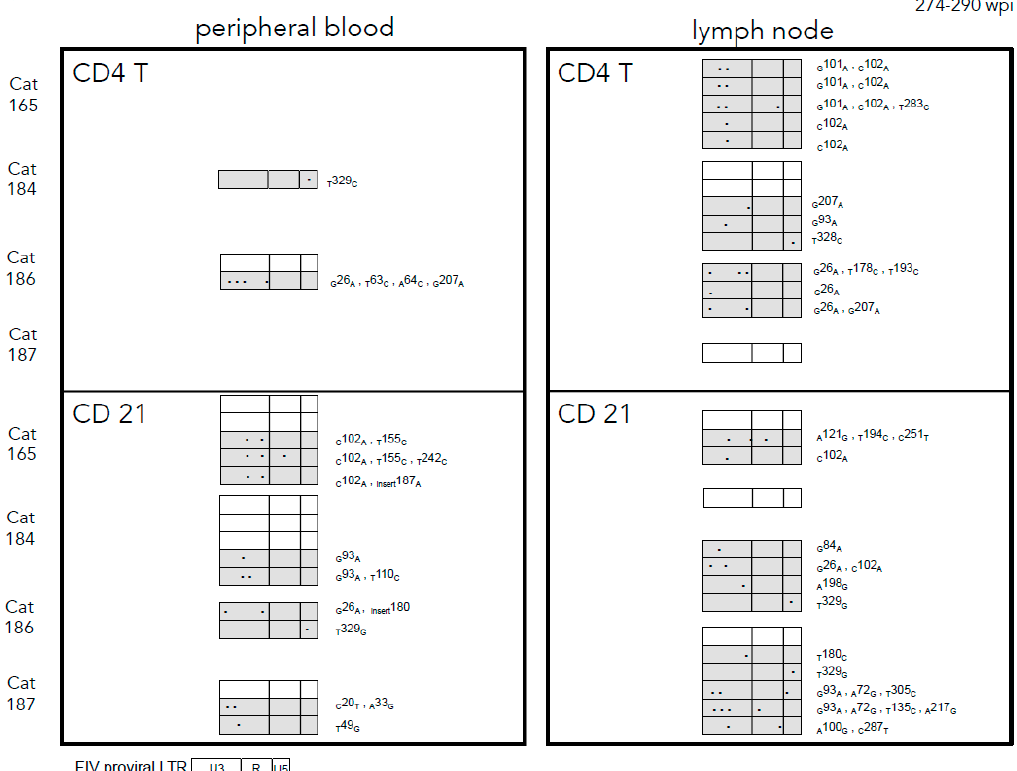
Figure 4. FIV proviral LTR variants in blood and popliteal lymph node-derived leukocyte subsets isolated from four asymptomatic FIV-infected cats (165, 184, 186, 187) between 274 and 290 wpi. Point mutations in the FIV LTR were detected in both leukocyte subsets of both compartments and most frequently occurred in the U3 region. Proviruses with point mutations or insertions were more commonly amplified than wild type (non-shaded rectangles). Shaded rectangles indicate that the proviral LTR sequence differed from the wild type inoculating virus. Proviral LTR DNA was not successfully amplified from blood-derived CD4+ cells in two of the FIV-infected cats (165, 187). Blood and popliteal lymph node tissues were collected concurrently from each cat. Each rectangle represents a sequence derived from a single clone.